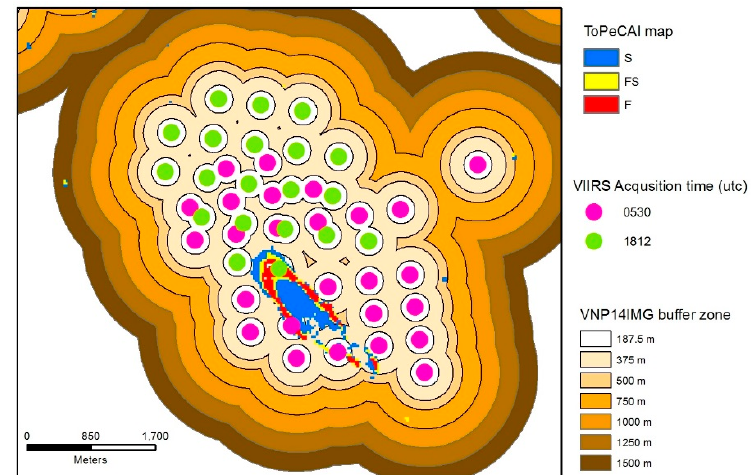
Figure 5. An example of buffering VNP14IMG point data overlaid with ToPeCAl results from Landsat-8. The VNPIMG data and ToPeCAl mapping relates to September 28, 2018. There is a 3 and 15 hour time difference from Landsat-8 to VNP14IMG acquisition times. The buffer zones are 187.5 m, 375 m, 500 m, 750 m, 1000 m, 1250 m, and 1500 m from both the VNP14IMG points (5:30 UTC and 18:12 UTC).